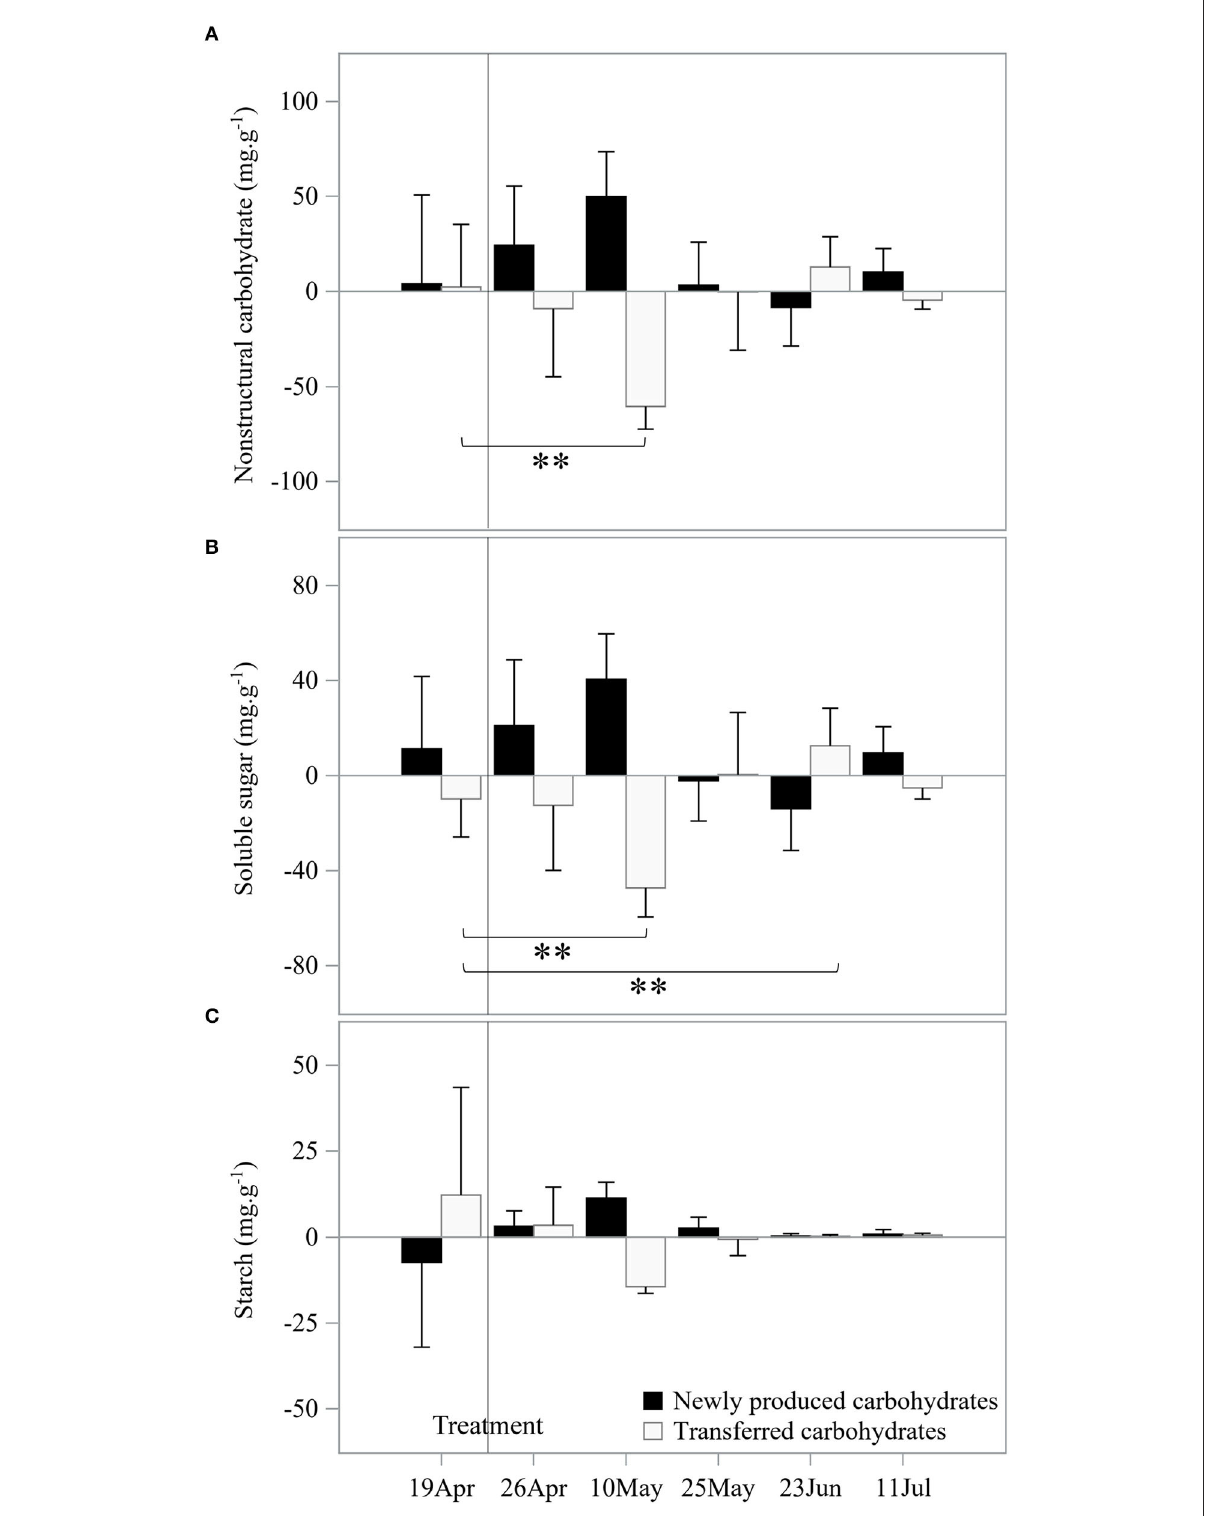
FIGURE3 Dynamics of transferred carbohydrates from stems of mother culms to newly sprouted culms and newly produced carbohydrates from leaves of mother culms over the experimental period. (A) The dynamics of non-structural carbohydrates, (B) the dynamics of soluble sugar, and (C) the dynamics of starch. ** Indicated a significant difference ( P < 0.01 ) between two data sets at the two ends of the